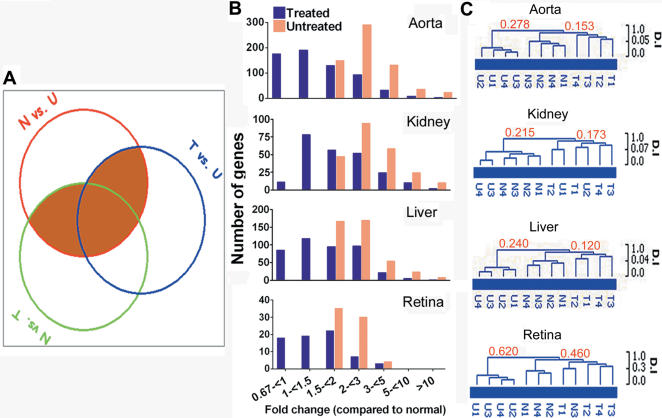
Transcriptional profiling of aorta, kidney, liver and retina.(A) Venn diagram of genes whose expression was significantly different in pairwise comparisons: N vs U; N vs. T and T vs. U (N, healthy controls; T, treated diabetic; U, untreated diabetic pigs. n = 2 per group). Genes ≥1.5-fold different in expression in pairwise comparisons were analysed by SAM (significance analysis of microarray) based on 1,000 permutations (false discovery rate <1%). Shaded areas denote diabetes-affected genes. (B) Expression of diabetes-affected genes in untreated and treated pigs grouped in increasing order of differential expression relative to healthy pigs. Genes represented by multiple probe sets were merged and averaged. (C) Unsupervised hierarchical clustering of diabetes-affected genes showed a distinct tendency for tissue transcriptomes of treated diabetic and healthy pigs to cluster together. Replicate transcriptional profiles of the same animal are designated 1 and 2, or 3 and 4 (i.e. 2 pairs of transcription datasets per group of 2 animals). Numbers on selected nodes of each dendrogram are the dissimilarity index (D.I.).